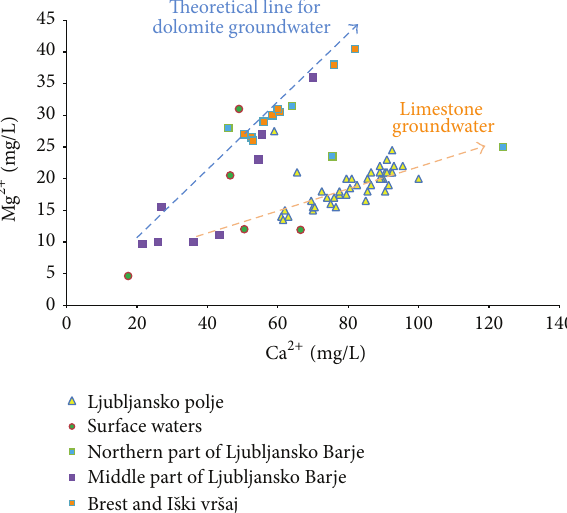
Figure 2: Relationship between HCO 3− and Ca 2+ in groundwater of Ljubljansko polje and Ljubljansko Barje aquifers. Roman numerals represent groups of groundwater from (I) Ljubljansko polje aquifer, (III)middle part of Ljubljansko Barje aquifer, and (IV) Brest and Iˇski vrˇsaj aquifer.